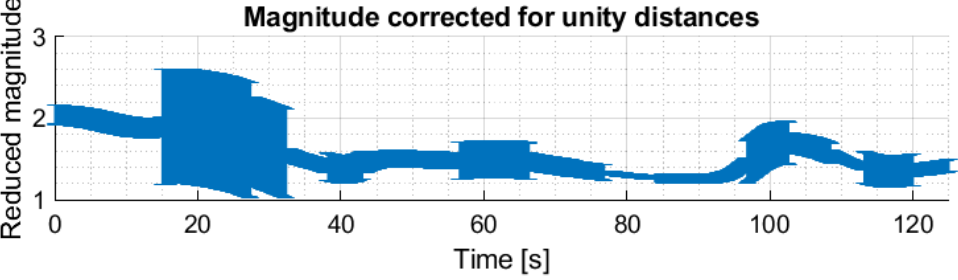
Figure 10. Observed light-curve of Cosmos 2322 Rocket (SSN 23704) taken the 25th August 2020 from RESDOS observatory.